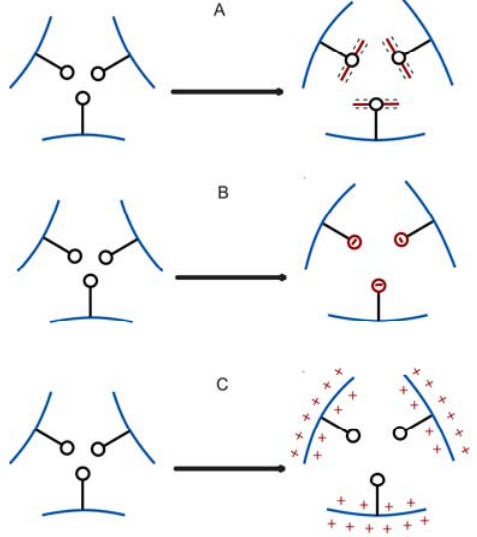
Figure 3. Schematic representation of osmotically-induced hydrogel swelling mechanisms: (a) binding of charged analyte molecules to the hydrogel binding sites [30], (b) generation of ionic species on the recognition element [33-35], (c) generation of ionic species on the sensitive polymer network